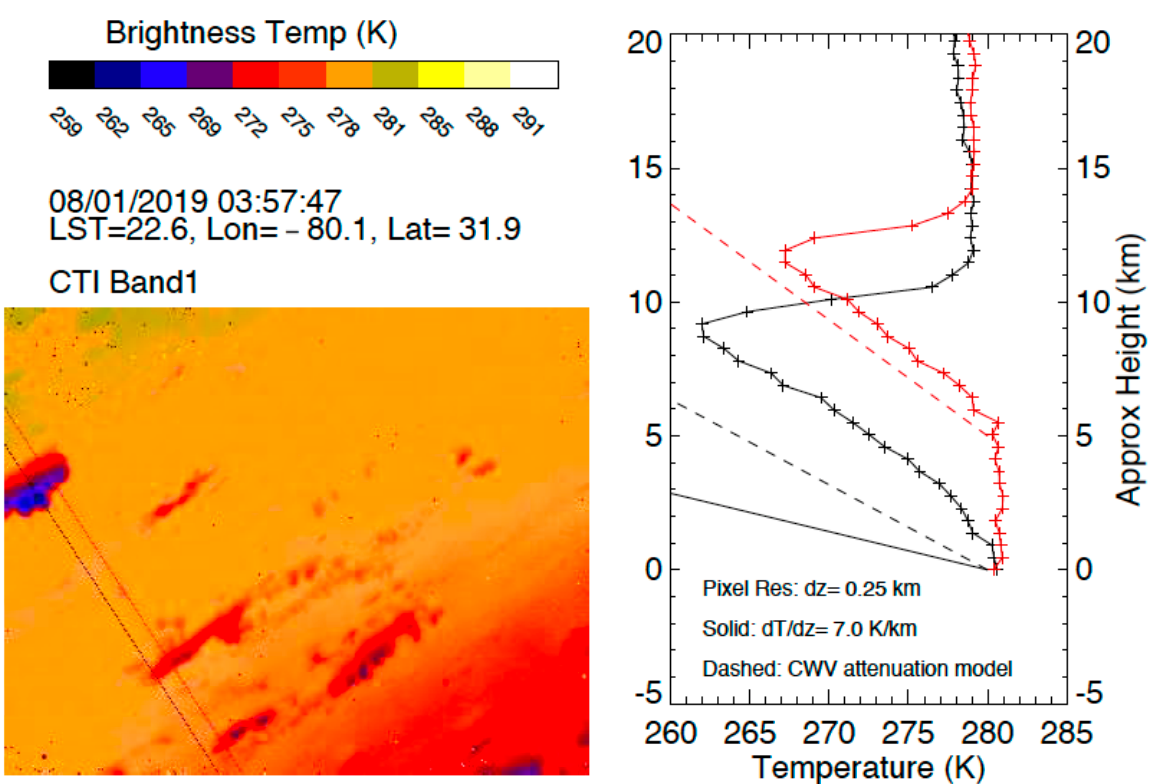
Figure 8. ( Left ) Cloud nighttime (LST = 22.6 h) image at a slant view from CTI band1 during the 1 August ISS pitch-up operation, with the limb in the bottom right direction. Unlike in Figure 6, the image is not rotated to have the limb at the top. ( Right ) Cloud temperature vertical profiles (lines with symbol) from two cuts through the CTI image as indicated by the dashed lines on the image. A temperature lapse rate of 7 K/km (solid line) is plotted along with cloud temperature profiles to guide the comparison on the right panel, where the dashed lines are temperature profiles with column water vapor (CWV) attenuation (see text). The CTI pixel resolution, ~250 m in the vertical direction as estimated from the viewing geometry at this slant angle, was used to profile the vertical thermal structure of cloud towers. The vertical axis is not the height above the surface but is used to illustrate the vertical temperature lapse rates. The red-line cloud is shifted up in the vertical axis because of its position in the tilted CTI